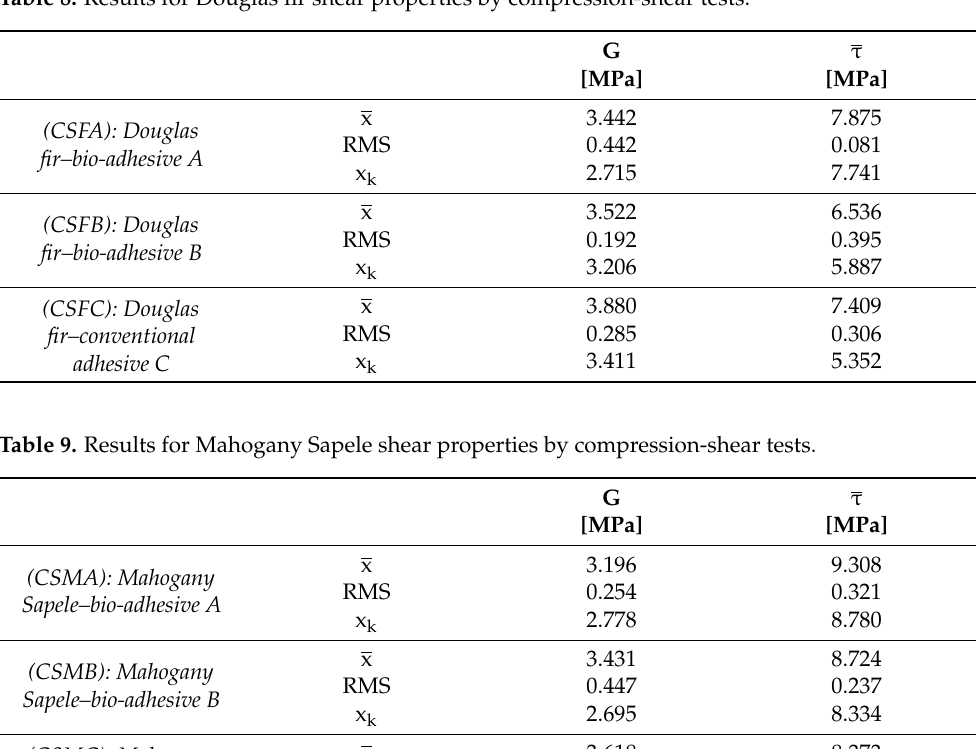
Figure 9. Typical force-displacement curve of a compression-shear test (CSMB07). Table 8. Results for Douglas fir shear properties by compression-shear tests.